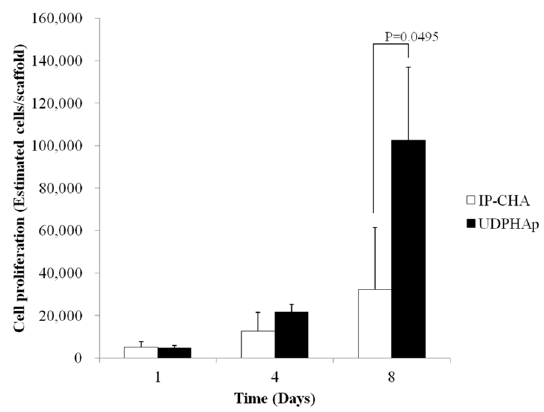
Figure 7. Cell proliferation. Days in culture and estimated number of MC3T3-E1 cells implanted onto IP-CHA and UDPHAp. Values are mean ± SD; n = 3 analyzed by Mann-Whitney U test.